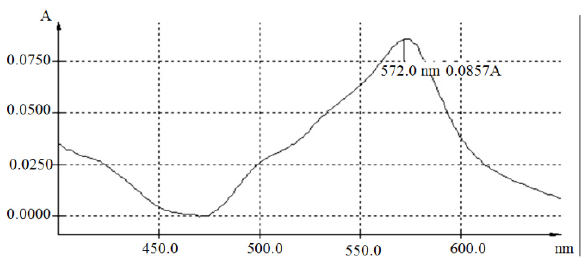
Fig. 5. Absorption spectrum of glucose solution P (3,3·10 -6 μg) with α-naphthol in acidic medium with urea additives (3 mg/ml and boric acid 6 mg/ml) As soon as urea and boric acid were added to the acidic medium (urea 3 mg/ml and boric acid 6 mg/ml), the sensitivity of the fructose reaction with α-naphthol increased approximately 6-fold, and the glucose sensi- tivity decreased 2-fold. The increase in the additive (urea and boric acids) in the solution of fructose and glucose with α-naphthol did not succeed, as the optical density of fructose drops significantly, and the optical glucose solution slightly increases (Fig. 6,